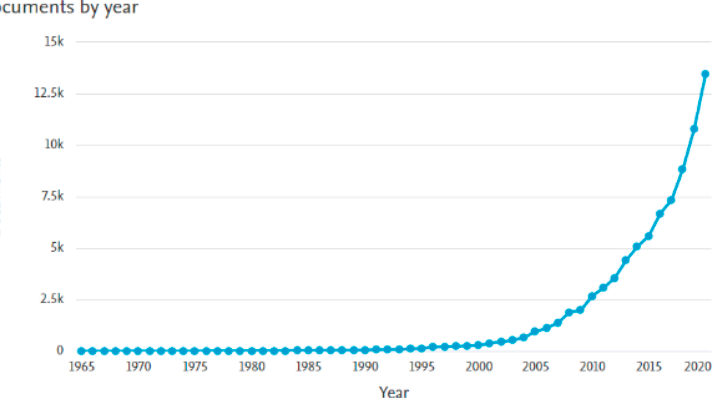
Figure 2. Number of publications concerning methods of evaluating transport and logistics compa- nies (1958–2020) nies (1958–2020) [5].